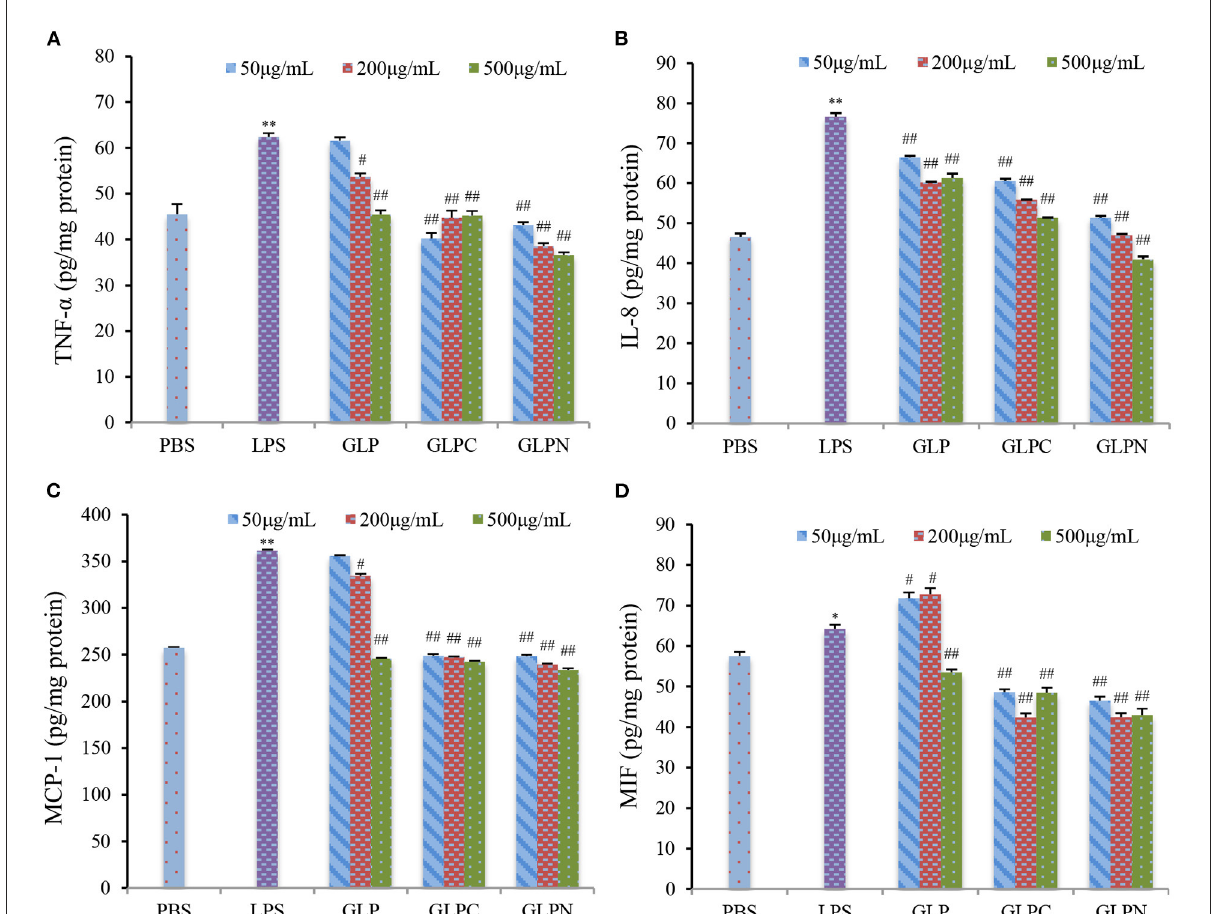
FIGURE5 Effects of GLP and the degraded fractions (GLPC and GLPN) on expression levels in Caco-2 cells induced by LPS (2 µ g/mL). TNF- α (A) , IL-8 (B) , MCP-1 (C) , and MIF (D) expression levels in cells were measured by ELISA. Data are presented as means ± SD ( n = 3). Significant differences with PBS group were designated as: * P < 0.05; ** P < 0.01. Significant differences with LPS-induced group were designated as: # P < 0.05; ## P <